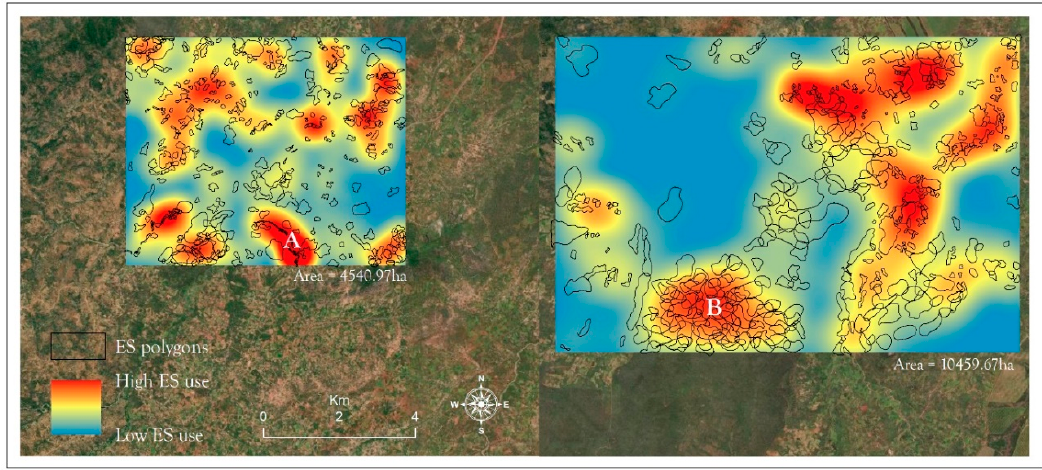
Figure 8. Patterns of ES use in Edundu (left) and Thimalala (right) with digitized polygons. Dark red areas indicate hotspots of ES use. The base map is from ESRI ArcGIS online base maps.